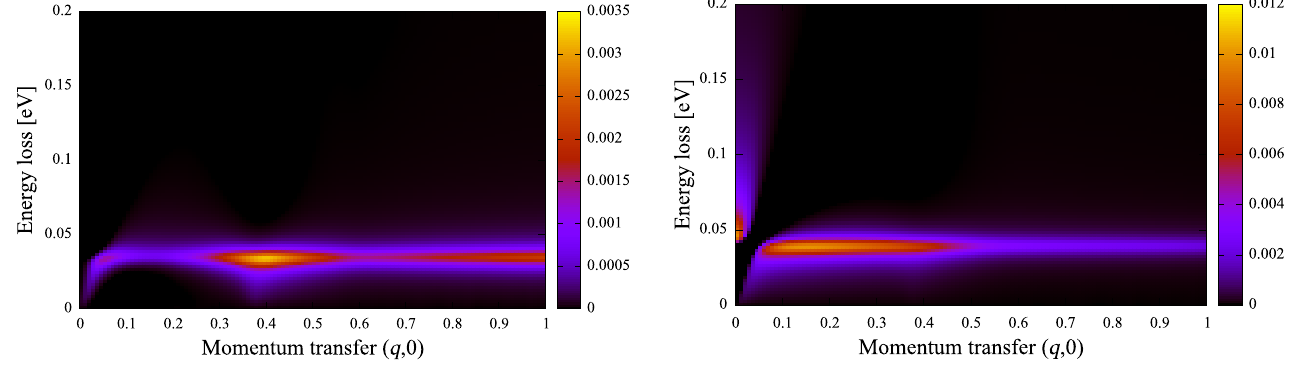
FIG. 6. A 1 phonon contribution to RIXS. Momentum transfer is given in units of π =a